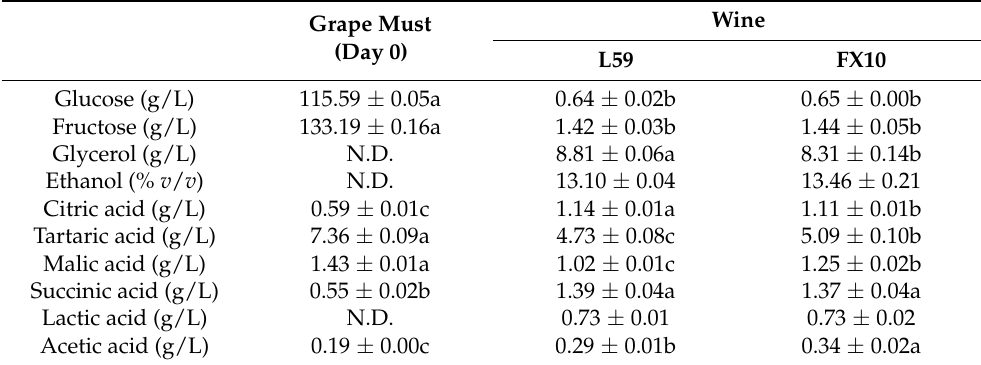
Table 1. The physicochemical indexes of Prince grape must and wine. Grape